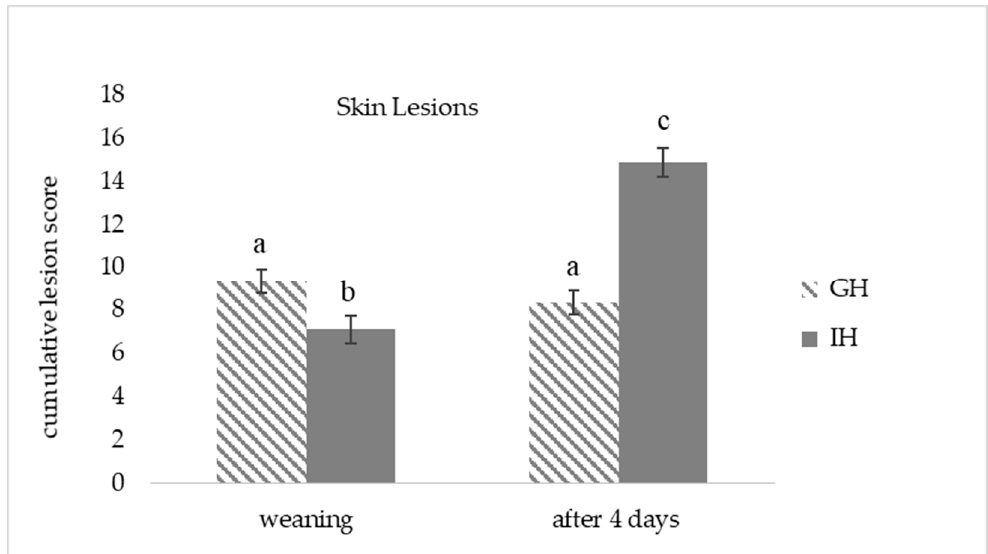
Figure 6. Least-Square-Means and standard errors (±SE) of the cumulative lesion score of the weaned piglets previously housed in pre-weaning GH (group housing n = 40) or in IH (individual housing n = 30). Significant differences are indicated by different letters ( p < 0.05).